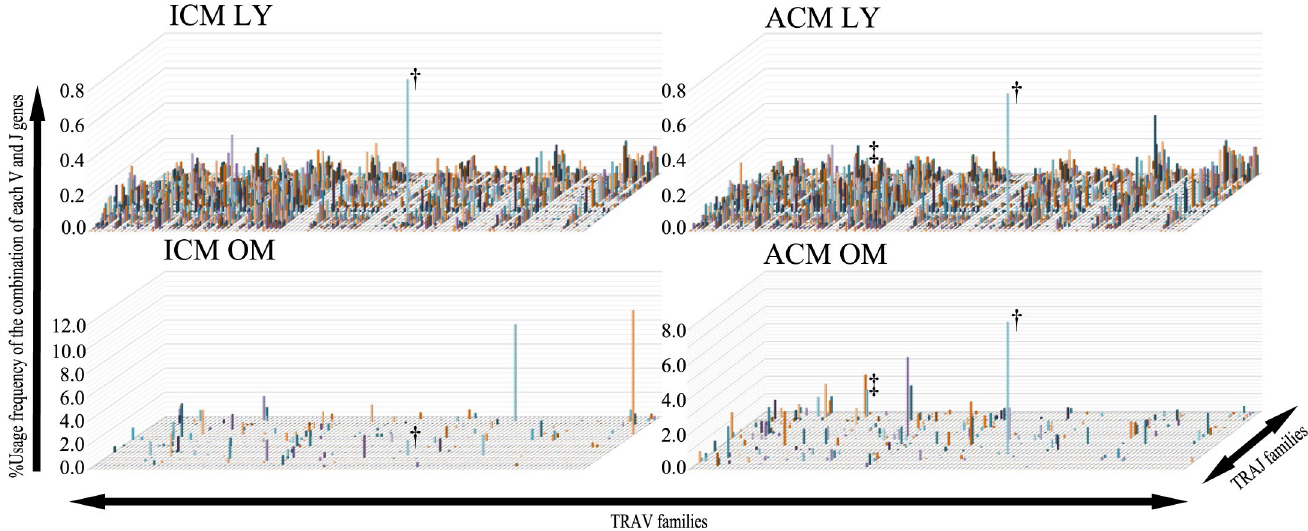
Fig 8. 3D Graphic analysis of the TRAV repertoire in ICM and ACM mice. TRAVJ repertoires were analyzed from the buccal mucosa and cervical lymph nodes of ICM and ACM mice at day 1 after challenge by NGS. 3D images of the TCR repertoire bearing a combination of TRV with TRJ genes show the skewing of T cells infiltrating the oral mucosa and cervical lymph nodes of ICM and ACM mice at day 1 after challenge. In the cervical lymph nodes, the percentage usage of Trav11d- Traj18 was high in ICM and ACM mice. The percentage usage of Trav11d-Traj18 was higher in the buccal mucosa of ACM mice compared with the buccal mucosa of ICM mice. †; TRAs bearing Trav11d-Traj18 , and ‡; TRAs bearing Trav6-6-Traj57 . OM; oral mucosa, and LY; cervical lymph nodes.